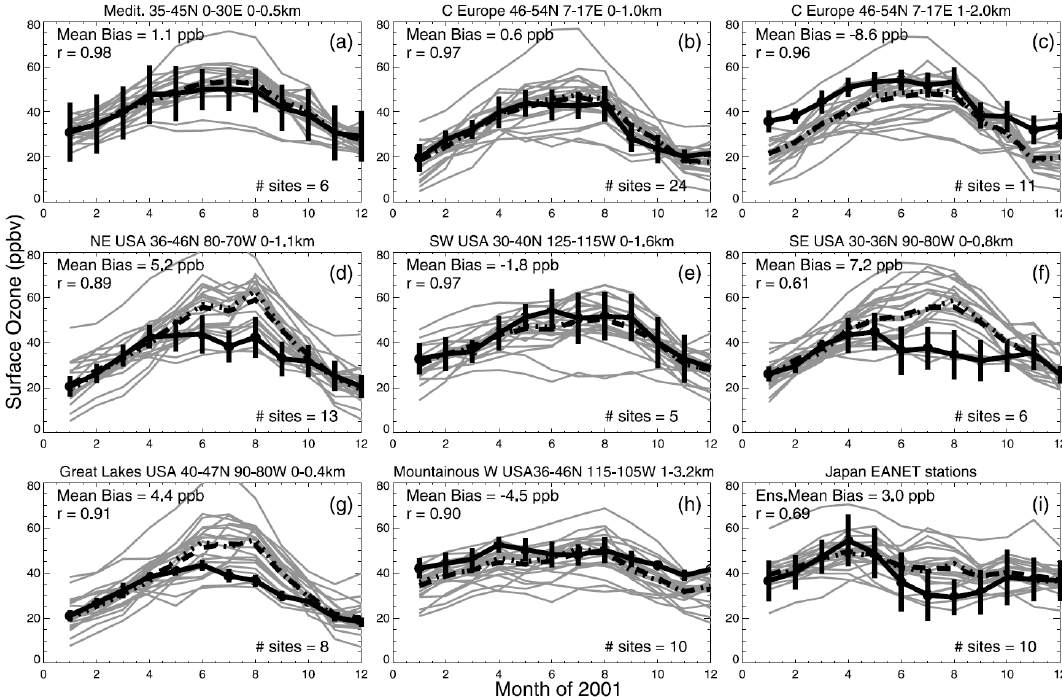
Figure 1. From Fiore et al. (2009): monthly mean surface O 3 concentrations (ppb) for the year 2001. Observed values (black circles) represent the average of all sites falling within the given latitude, longitude, and altitude boundaries and denoted by the symbols in Fig. 1; vertical black lines depict the standard deviation across the sites. Monthly mean O 3 in the surface layer of the SR1 simulations from the 21 models are first sampled at the model grid cells containing the observational sites and then averaged within subregions (grey lines); these spatial averages from each model are used to determine the multimodel ensemble median (black dotted line) and mean (black dashed line). Observations are from CASTNET (http://www.epa.gov/castnet/) in the United States, from EMEP (http://www.nilu.no/projects/ccc/emepdata.html) in Europe, and from EANET (http://www.eanet.cc/eanet.html) in